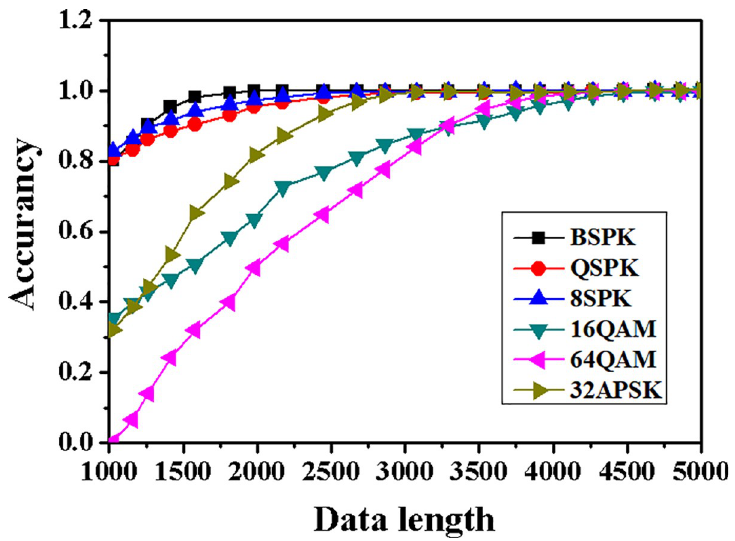
Fig 7. Variation of recognition accuracy of modulation signals with different data lengths.